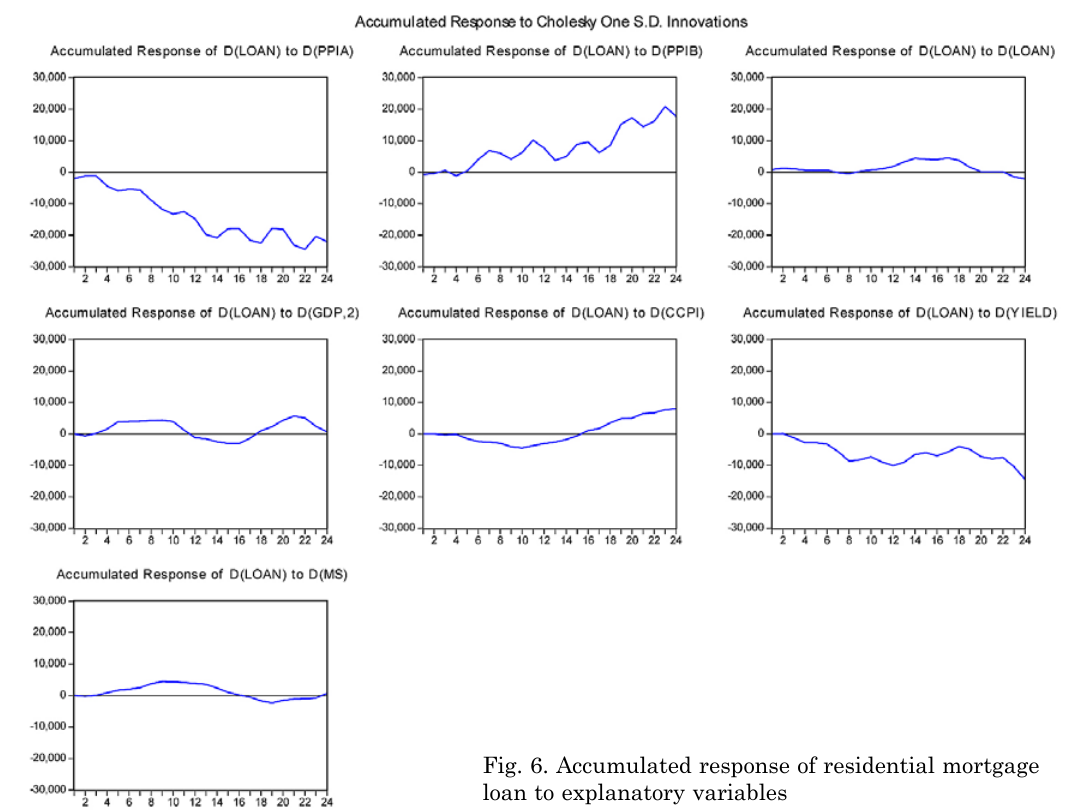
Fig. 6. Accumulated response of residential mortgage loan to explanatory variables